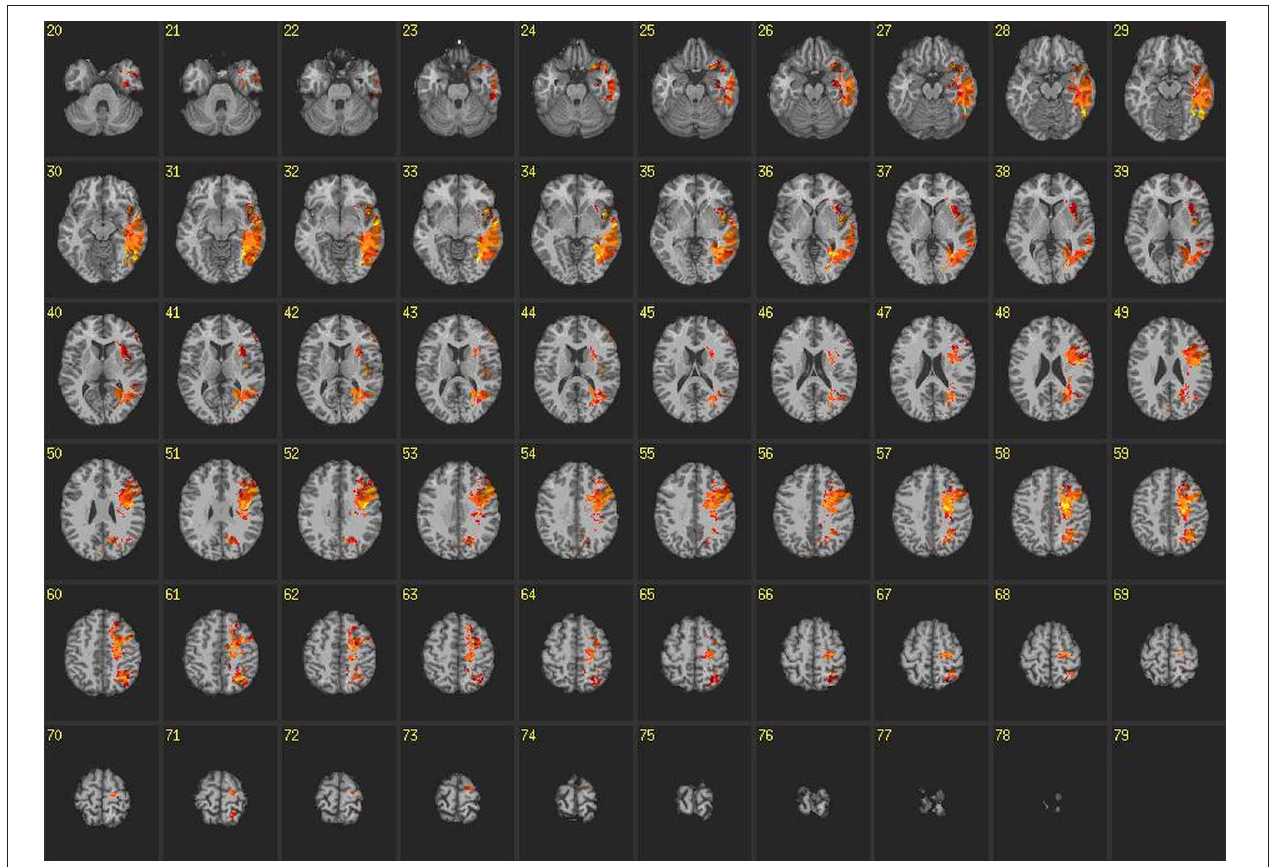
FIGURE 4 | Voxel-based lesion-symptom maps: congruent blocks. VLSM maps for reaction times on congruent blocks of the IAT. Colored voxels are significant at p < 0 . 05 correcting for multiple comparisons. Brighter colors indicate stronger statistical effects.